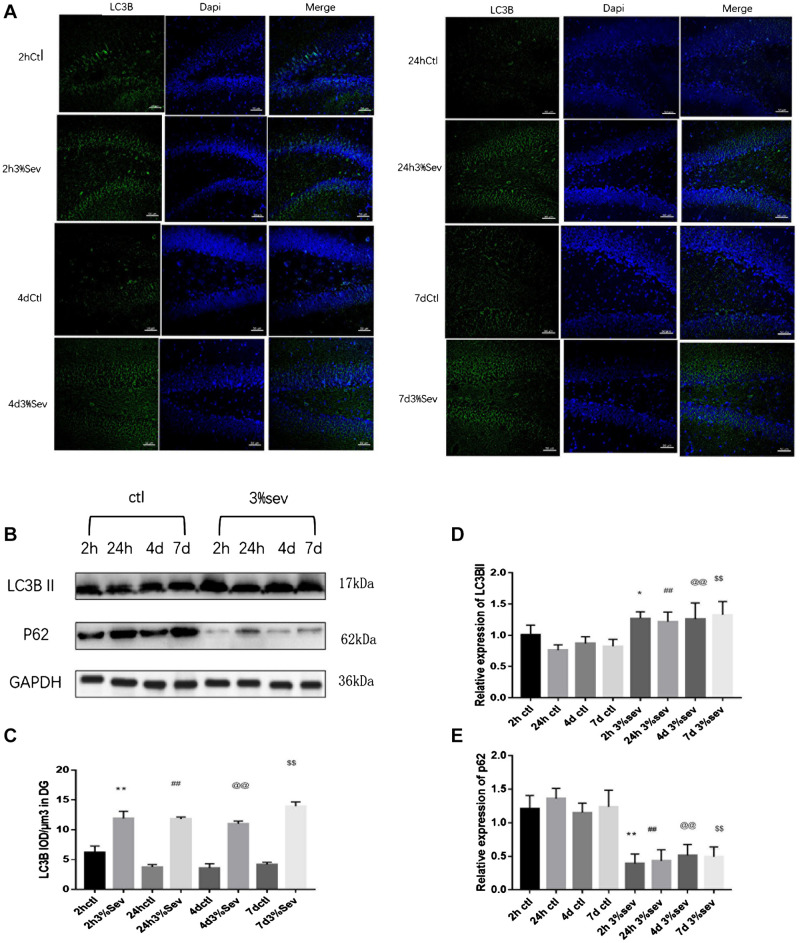
(A) Sevoflurane increased LC3B expression in DG region 2 h, 24 h, 4 days, and 7 days after anesthesia. Scale bar = 50 μm. (B) Sevoflurane upregulated LC3BII and decreased P62 expression in DG region 2 h, 24 h, 4 days, and 7 days after anesthesia. (C) Quantification analysis of the fluorescence intensity of LC3B/μm3 in the DG. n = 3. (D) Quantification of LC3BII. (E) Quantification of P62. n = 3. Values are presented as mean ± SD; *P < 0.05 compared with the 2-h control group, **P < 0.01 compared with the 2-h control group, ##P < 0.01 compared with the 24-h control group, @@P < 0.01 compared with the 4 days control group, $$P < 0.01 compared with the 7 days control group. One-way ANOVA with Newman–Keuls post hoc test or Kruskal–Wallis with Dunn’s Multiple comparison test was used for data analysis.